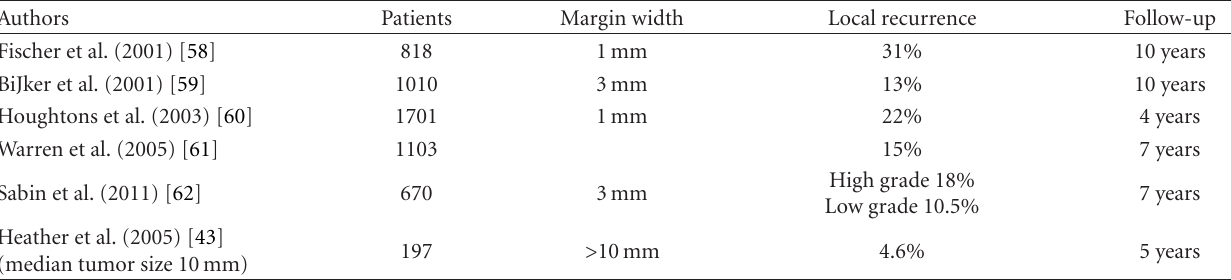
Table 5: Breast conservative surgery (BCS) results without RT.